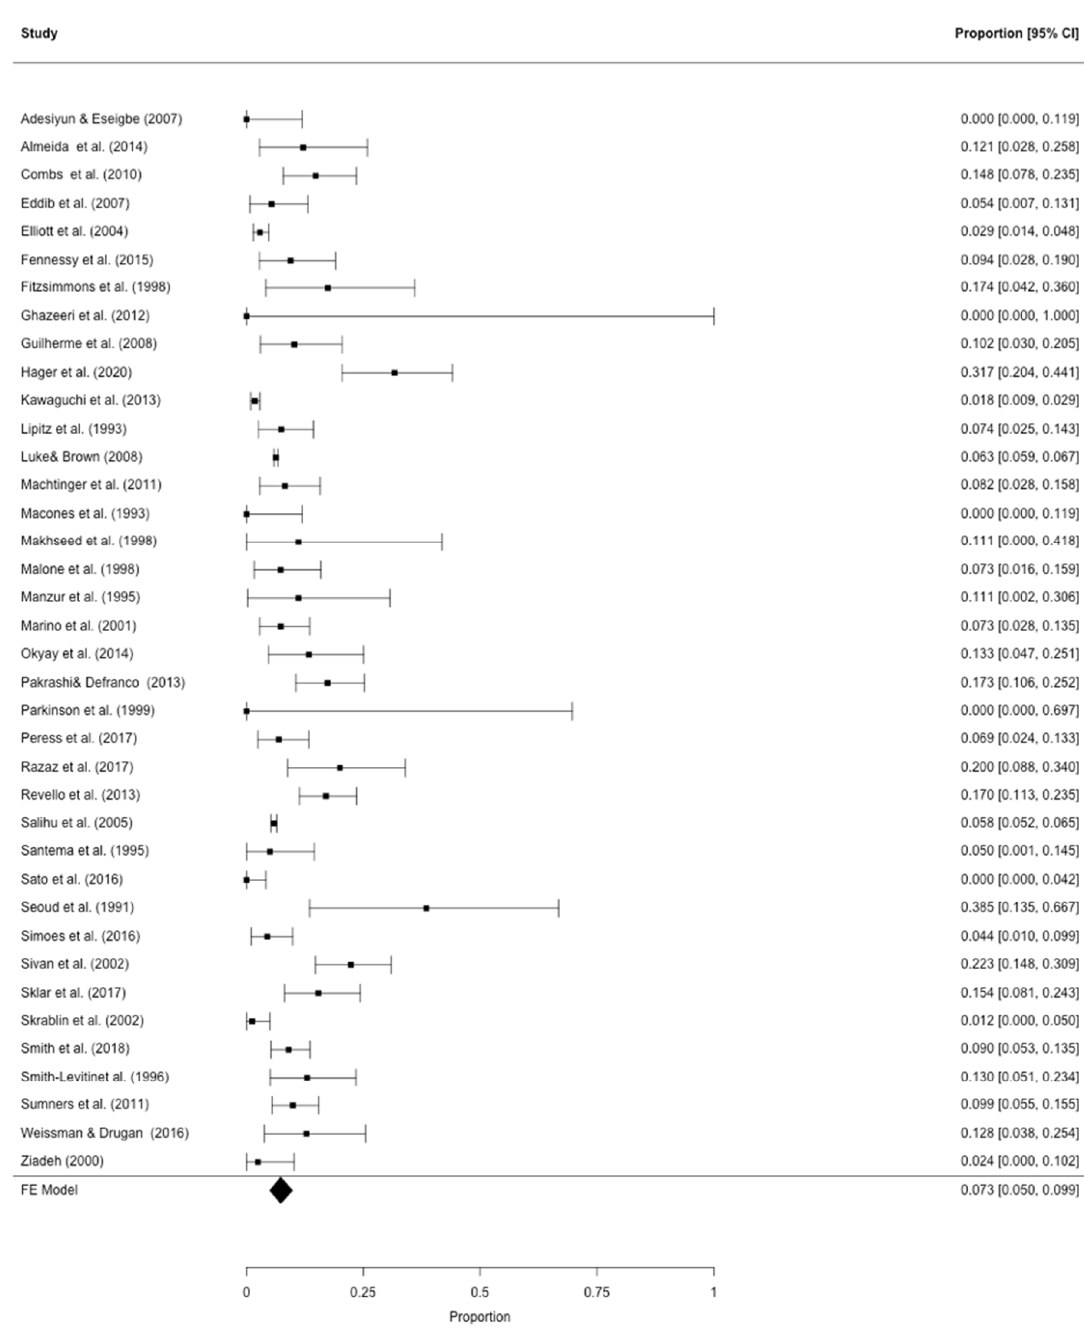
Figure 2. Meta-analysis of all 38 eligible studies on GDM prevalence in triplets [9,25–60].